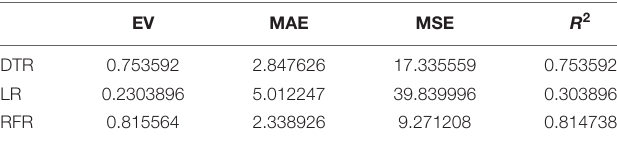
TABLE 3 | Regression index of the conscientiousness model.